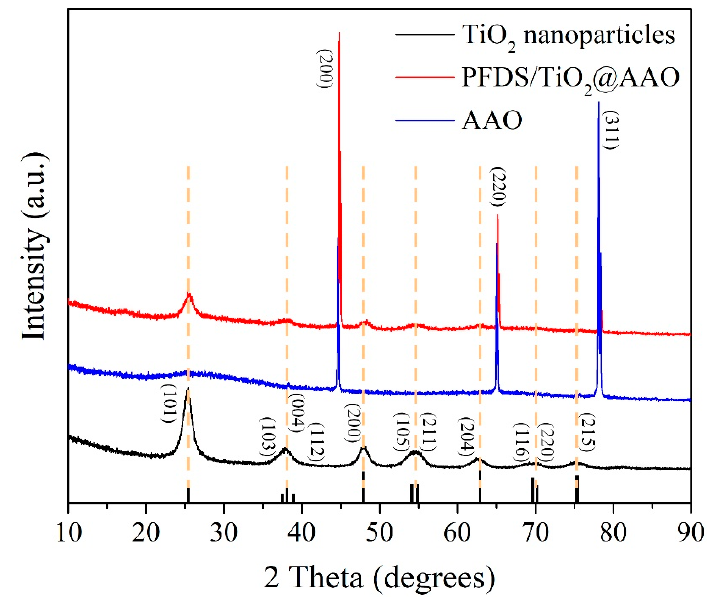
Figure 4. TOF-SIMS for quantificationally determining the elements including Al, Ti, Si, C, O, and H of the coating.